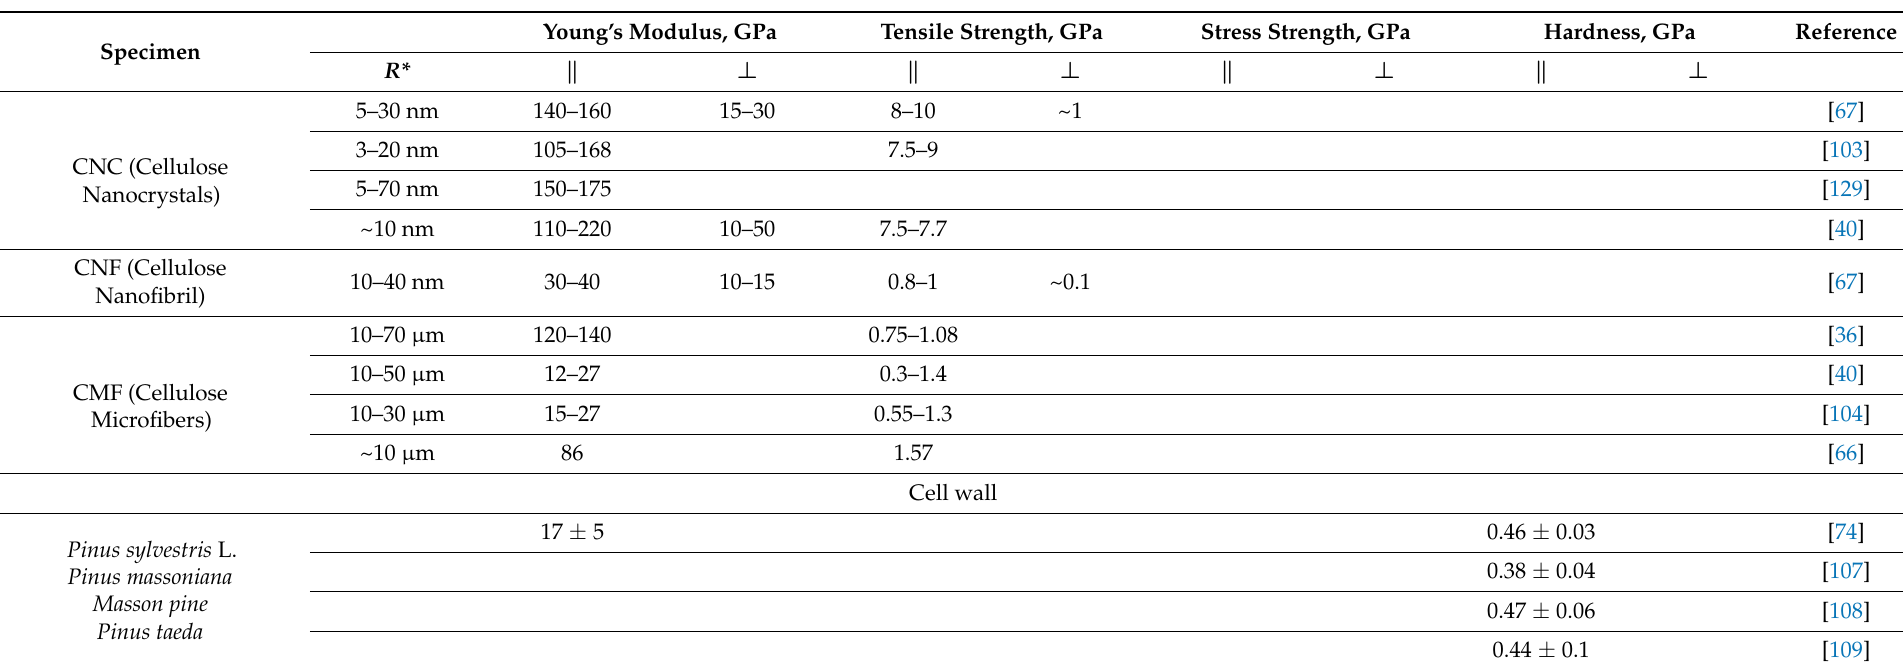
Table 4. Some mechanical properties of wood structure